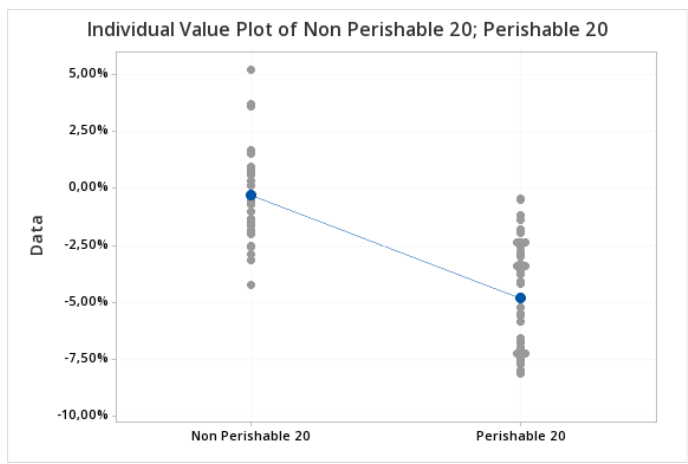
Figure 13. Individual plot CAARs event window E ( − 20, + 20).